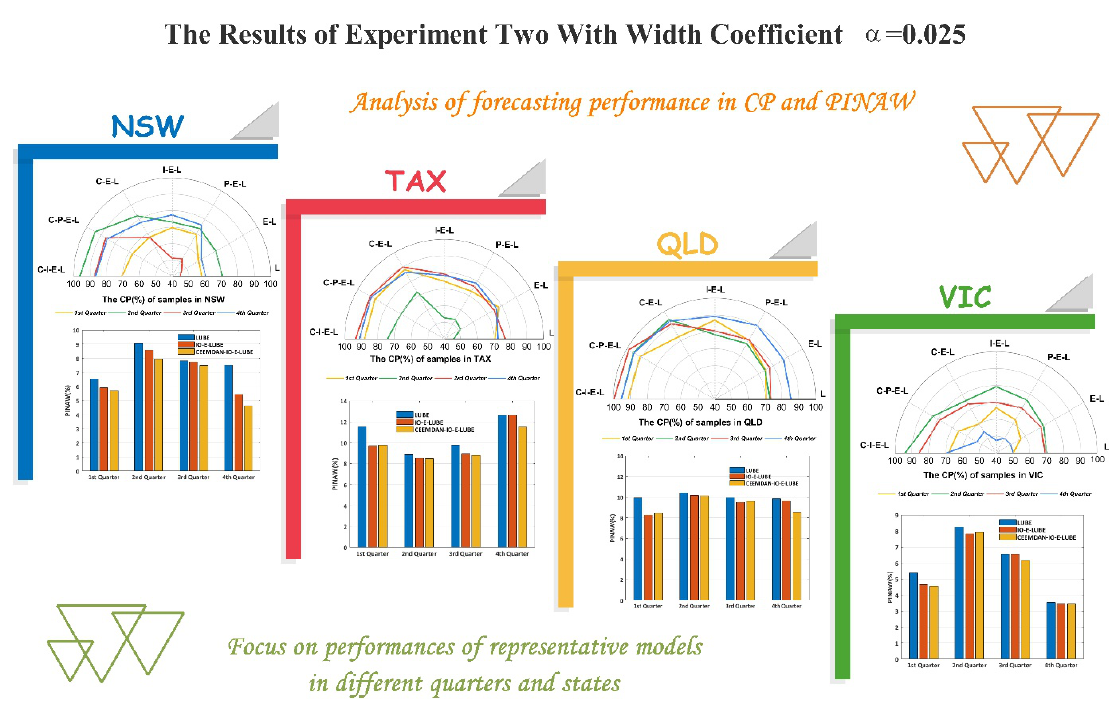
Figure 6. Performance of different samples with the width coefficient 0.025.